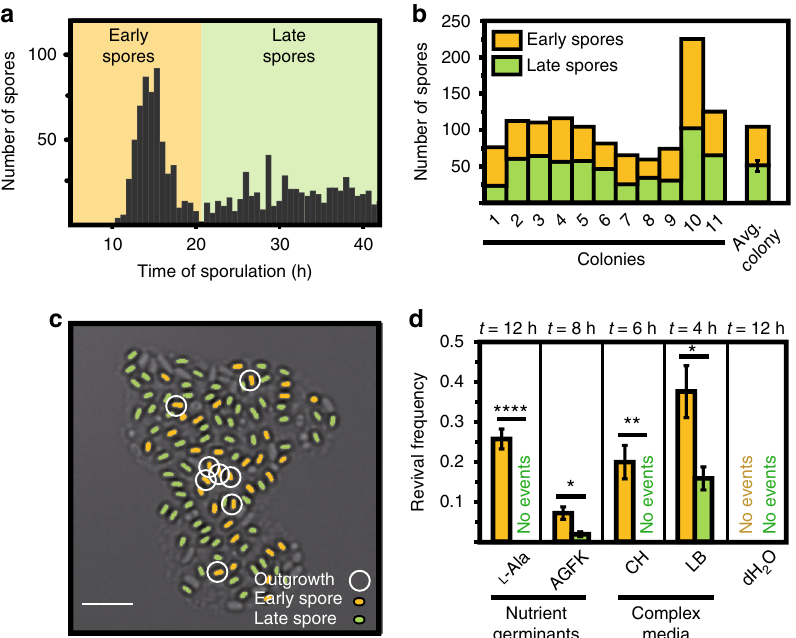
Fig. 2 Nutrient-induced spore revival correlates with the timing of sporulation during starvation. a Distribution of sporulation times. Spores were classi fi ed into early (yellow) and late spores (green). The number of tracked spores is n s = 1013 from n c = 10 microcolonies obtained from n e = 3 independent experiments. b Total number of early and late spores in different microcolonies. c False-colored bright- fi eld image of a microcolony generated by a single vegetative cell, visualized after 90 h of starvation, and showing the distribution of mature spores. Yellow denotes early spores and green late spores. The subset of spores that grew out in response to stimulation with L -alanine within the fi rst 12 h is circled. Scale bar: 5 µ m. d Revival frequencies of early and late spores in response to stimulation with L -Ala ( L -alanine), AGFK ( L -asparagine, glucose, fructose, potassium), CH (casein hydrolysate medium), LB (luria broth), and H 2 O (water). See Methods for details. Strain: BIB1019, data: mean ± SEM from n c ≥ 4 ( n s ≥ 500), unpaired t test: * P ≤ 0.05, ** P ≤ 0.01, *** P ≤ 0.001, **** P ≤